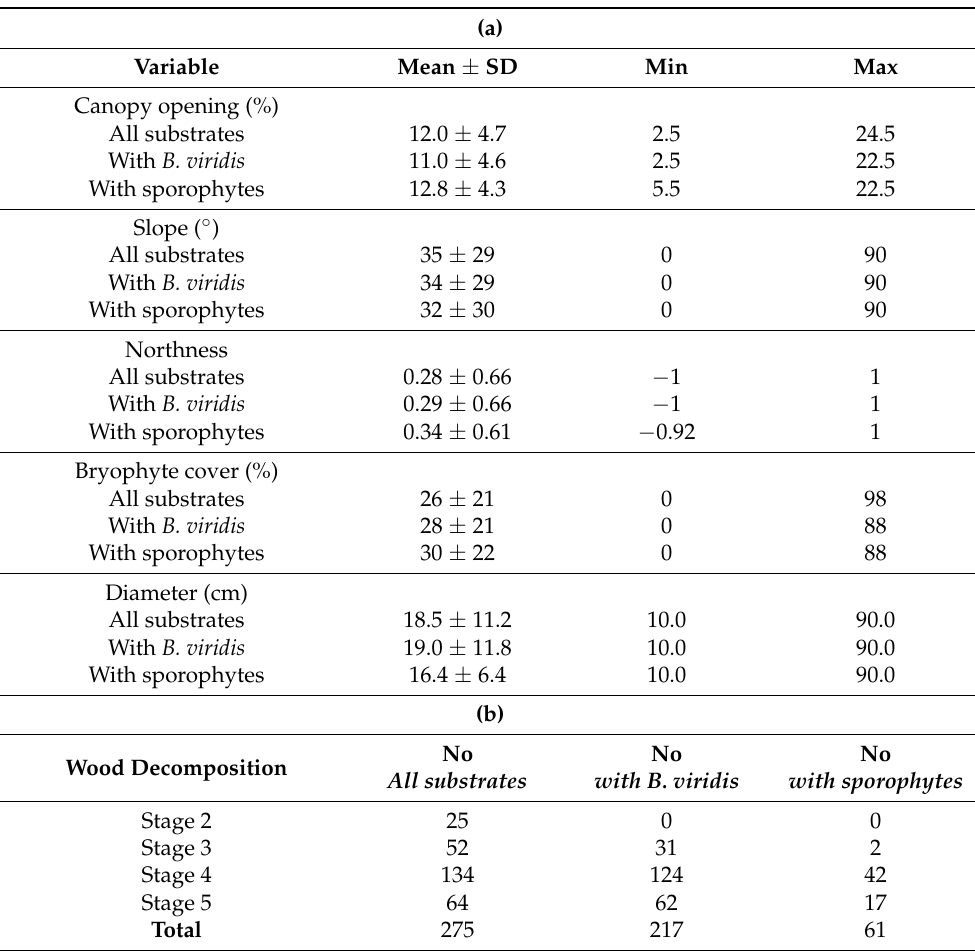
Table 3. Description of the set of microenvironmental quantitative variables (a) and